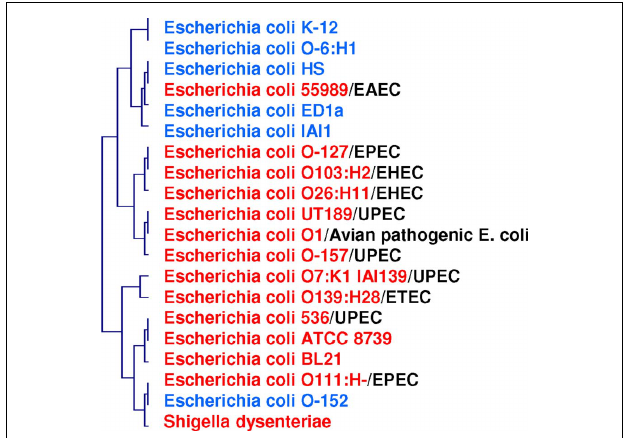
FIGURE 4 | Phylogenomic tree based on whole gene content (present/absent genes) in pathogenic and non-pathogenic E. coli species and S. dysenteriae. Two clusters are formed: one for pathogenic species (in red), and one for non-pathogenic species (in blue). Pathogenic strains are divided into five groups: EPEC, enteropathogenic; EHEC, enterohemorrhagic; UPEC, uropathogenic; ETEC, enterotoxigenic; EAEC,